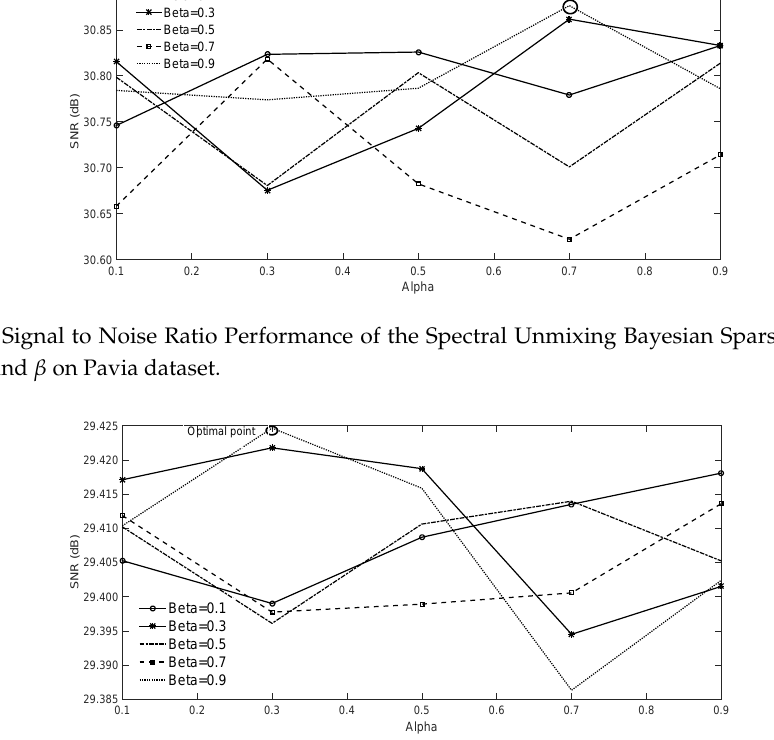
Figure 3. Signal to Noise Ratio Performance of the Spectral Unmixing Bayesian Sparse Algorithm Versus α and β on Shiraz